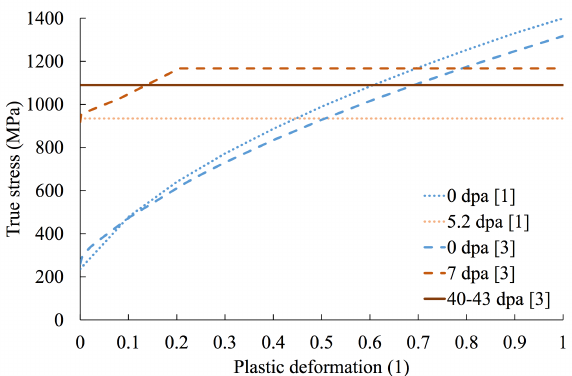
Figure 1. Plastic response of studied neutron radia- tion damages